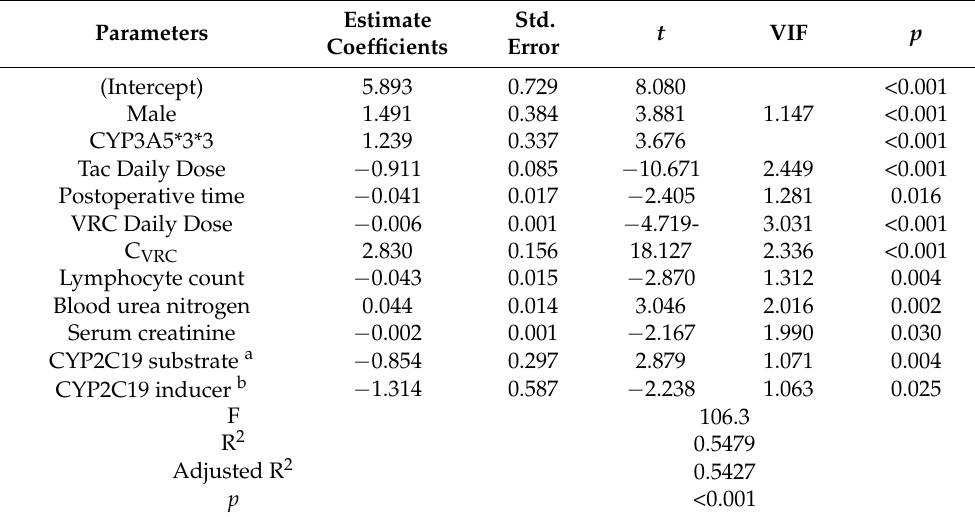
Table 6. The independent influencing factors of C/D. Estimate Parameters